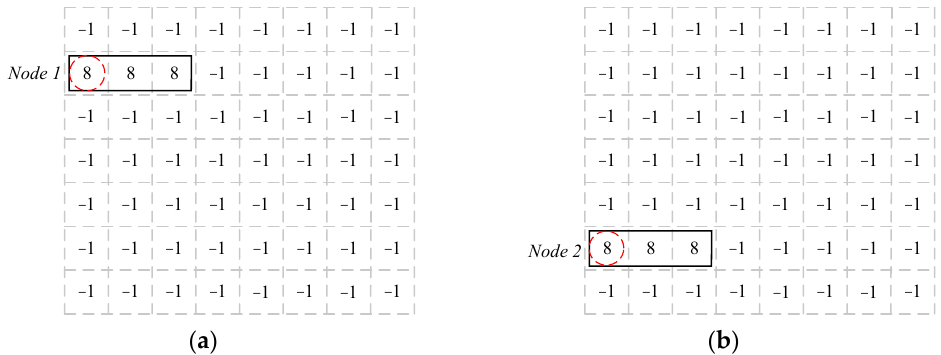
Figure 4. ( a ) An example of initial chiplet placement; ( b ) symmetrical placement with the same mapping effect.